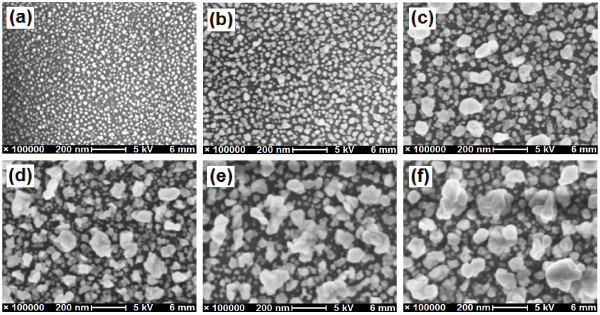
SEM images of AgNPs multilayer films on glass slides prepared in a AgNO3/BuNH2 (5/2.5 mM) ethanolic solution with different reaction times: (a) 1.5 h, (b) 2 h, (c) 5 h, (d) 18 h, (e) 25 h, and (f) 40 h.